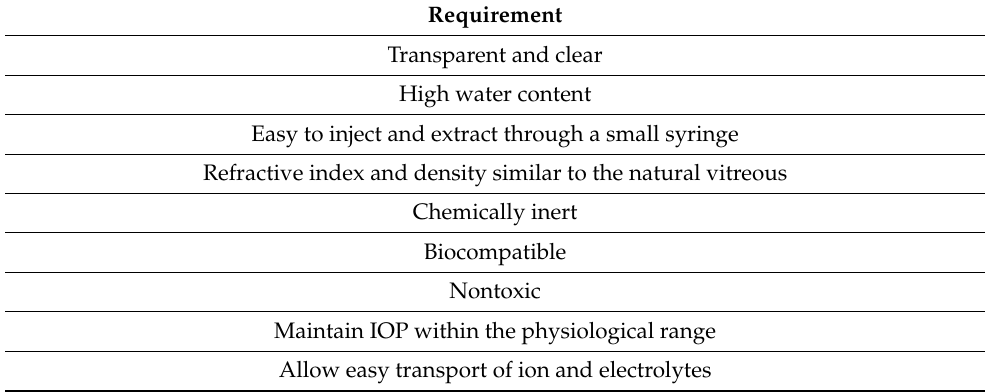
Table 3. Characteristics of an ideal vitreous substitute